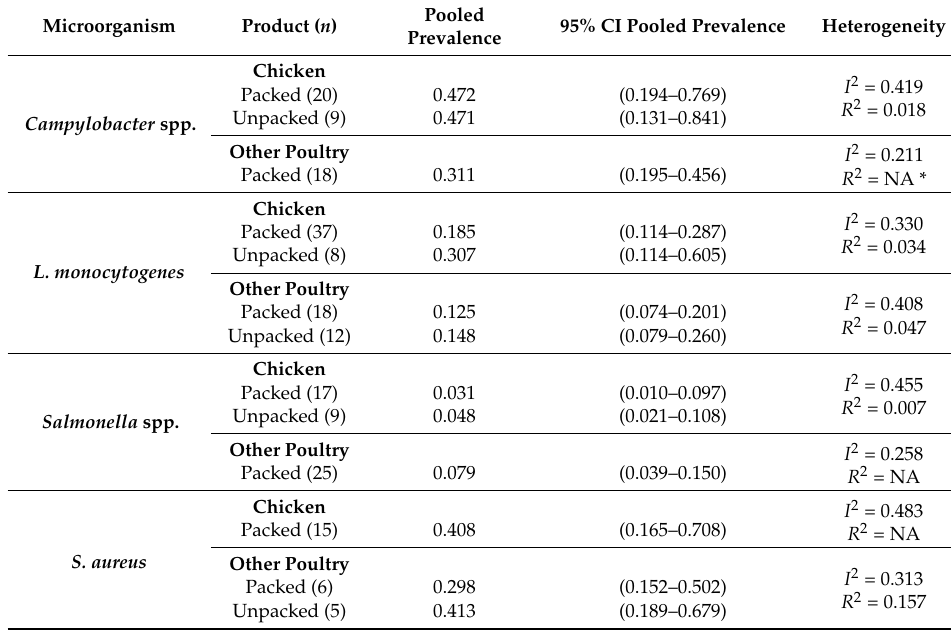
Table 3. Meta-analysis of the incidence of pathogens in chicken and other poultry meat by packaging status. Heterogeneity analysis comprises between-study variability to total variability ratio ( I 2 ) and proportion of between-study variability explained by packaging status ( R 2